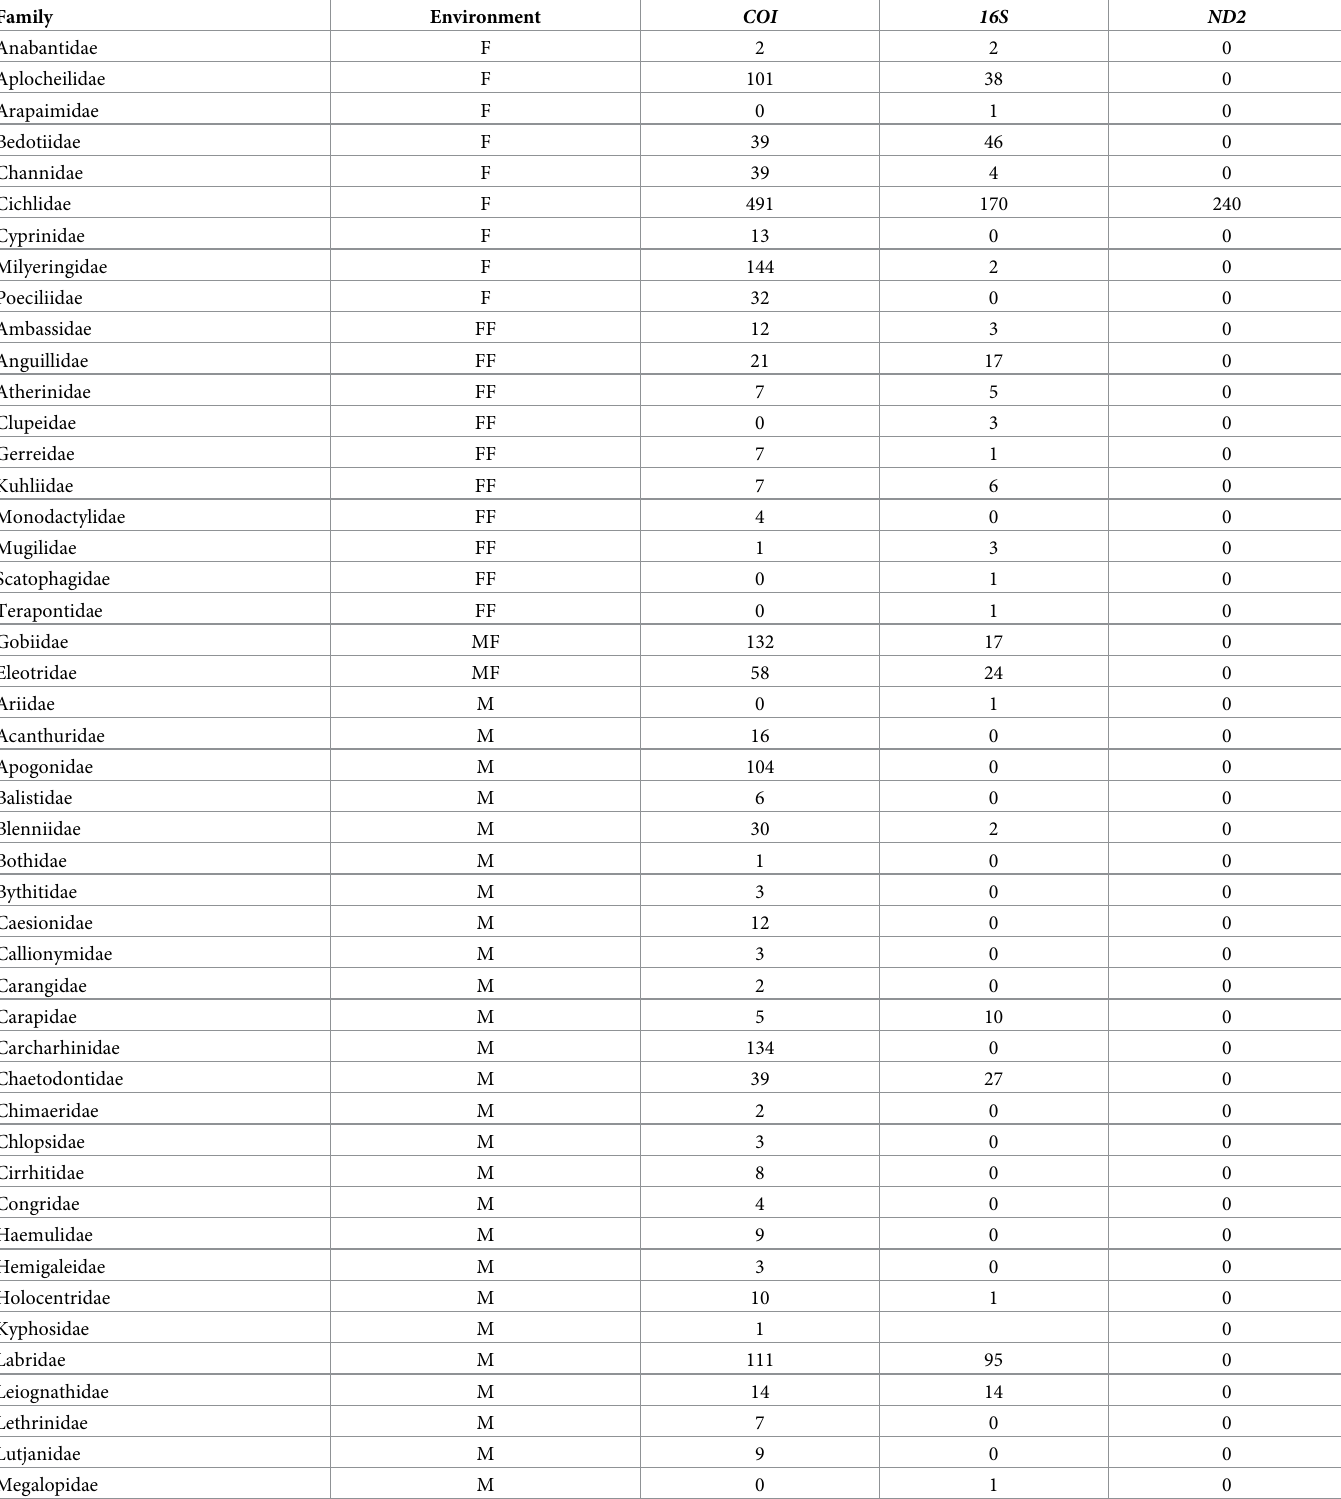
Table 1. Counts of sequences in our DNA barcode library of Malagasy fishes for three mitochondrial DNA fragments ( COI , 16S and ND2 ).